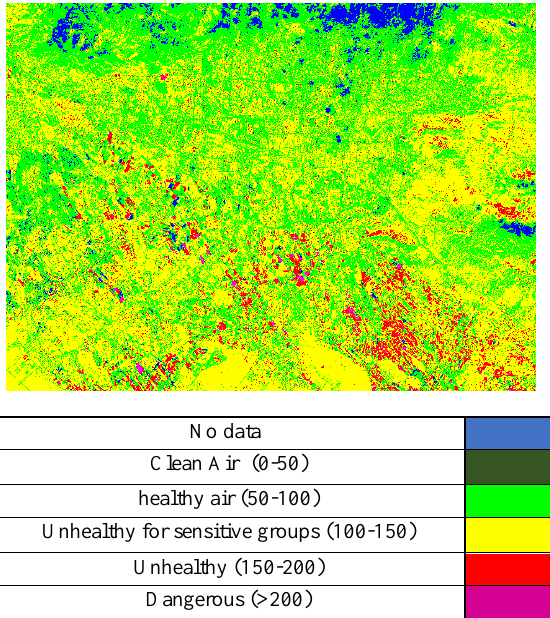
Figure3. PM10 map for January-2018 After producing the contamination model, the effect of vegetation cover was investigated. At this step the two images of lansat-8 are almost identical in terms of traffic and weather conditions, NDVI vegetation index is applied to both images (figure 4). Figure A is the air pollution map and figure B is the vegetation map of the first image taken in February, and figure C is the air pollution map and figure D is the vegetation map of the second image. Which was photographed in late March. The sharp decline in vegetation in Tehran's green areas has increased pollution in areas with high potential for air pollution. This comparison shows that if vegetation increased by up to seventy percent, the amount of pollutants in the atmosphere (especially particle material) decreases from average 120 µg / m3 (risk zone for sensitive groups) to 65 µg / m3 (safe zone).